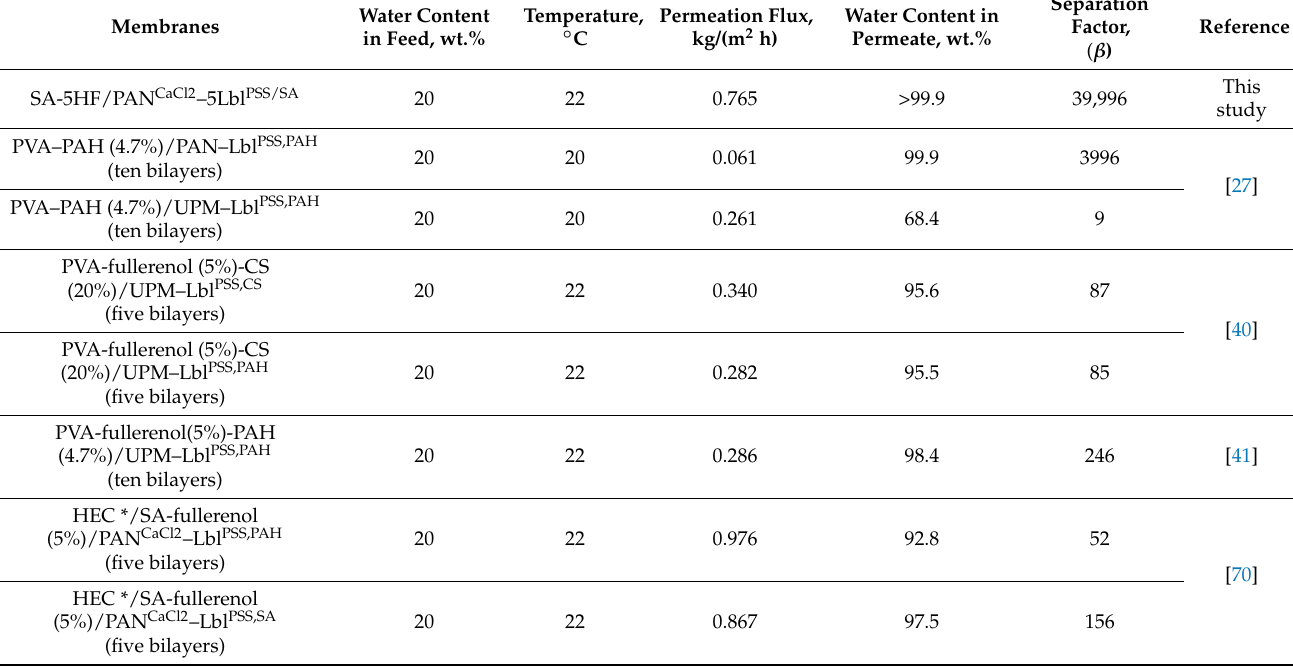
Table 6. Comparison of the transport properties of the membranes with surface modification (the deposition of PEL layers) in the pervaporation dehydration of isopropanol. Water Content Membranes in Feed,